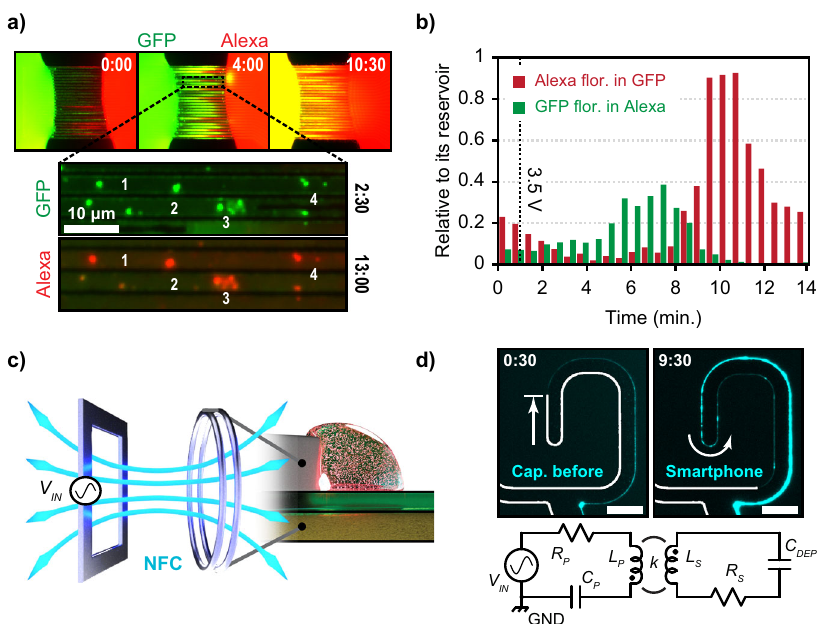
Fig. 4 Wireless smartphone actuation and lateral fl ow protein labeling. a A green fl uorescent protein (GFP) reservoir drop (green) and Alexa Fluor-594 reservoir drop (red) were mixed using 25 parallel channels after applying 3.5 V RMS . Conglomerates of GFP were extruded from the GFP reservoir into individual OMEF channels and were labeled red by the Alexa dye after mixing using amine chemistry. b Alexa fl uorescence intensity in the GFP reservoir is plotted versus time (red) and normalized to its source-reservoir fl uorescence at the same time point. Similarly, GFP fl uorescence inside the Alexa reservoir is also plotted versus time (green). An exchange in reservoir material is observed for both solutions. Source data are provided as a Source Data fi le. c Schematic demonstrating wireless inductive coupling of magnetic fi elds to actuate liquid. d Demonstration of wireless smartphone actuation of PBS using an NFC signal. Images are from before (left) and after (right) smartphone-powered actuation was applied, where the solution was pulled an additional ~200 µ m beyond the capillary action while increasing the channel width throughout its entire length. The electrode edge is outlined in white for reference. Scale bar is 25 µ m. Below is an example of a resonant wireless power-transfer circuit using a primary inductor ( L P ), capacitor ( C P ), and resistor ( R P ) (LCR) circuit to transfer power to a secondary LCR with an inductance ( L S ), resistance ( R S ), and circuit capacitance of our device, C DEP